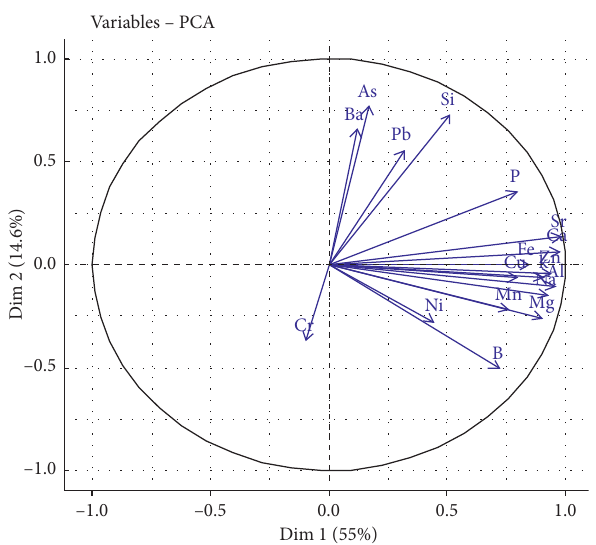
Figure 1: Superimposed representation of